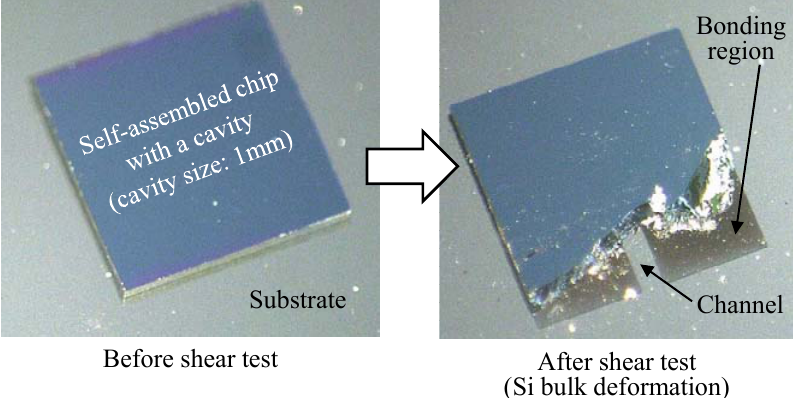
Figure 11. Shear bonding strength measurement of a self-assembled chip with a smaller cavity to a Si substrate.